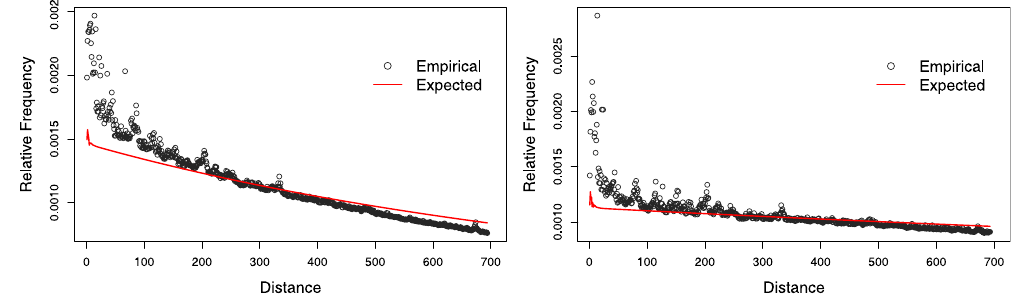
Figure 1. Empirical and expected global DNRC distributions, for the complete human genome, for k = 6 (left) and k = 7 (right). The expected distributions were obtained under the k -order Markov dependence assumption.